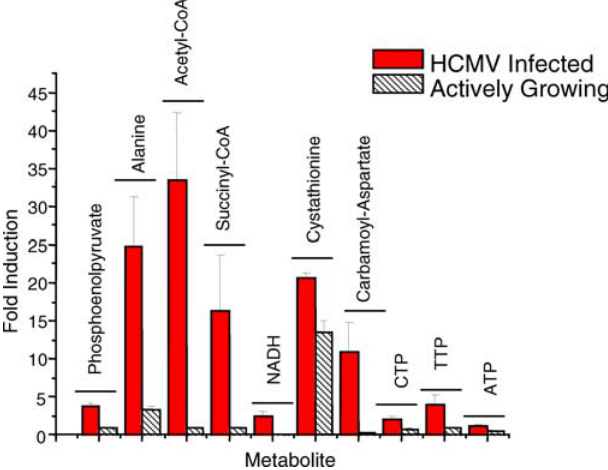
Figure 8. HCMV Infection Disrupts Normal Homeostatic Metabolite Pool Levels Metabolite levels in HCMV-infected quiescent fibroblasts (72 hpi) and actively growing fibroblasts are reported as fold-induction over quiescent, uninfected cells (mock 4 h). To account for differences in cell count and cell size between conditions, all results are normalized to total protein levels. Bars represent the mean fold-induction from two independent experiments performed in duplicate ( n ¼ 4), with the error bars showing þ 1 SE of the mean.